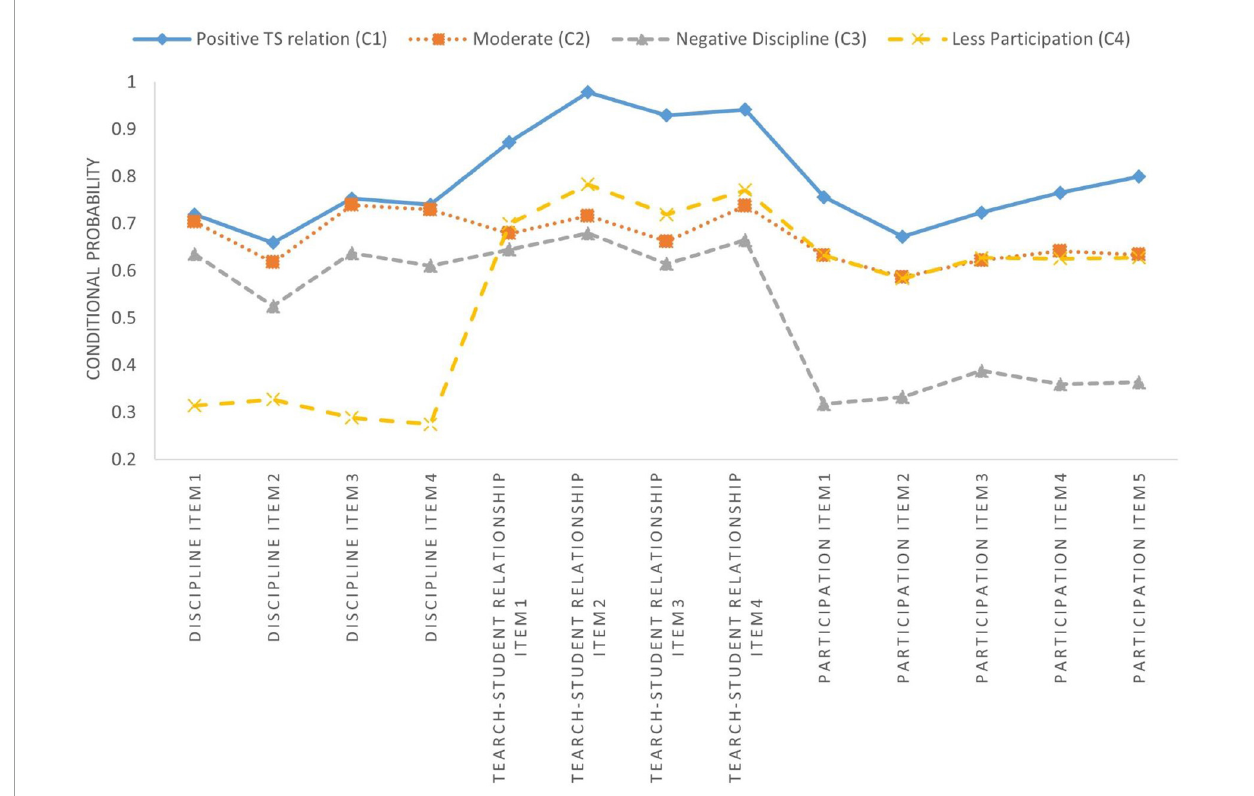
FIGURE3 Latent classes of the Finland